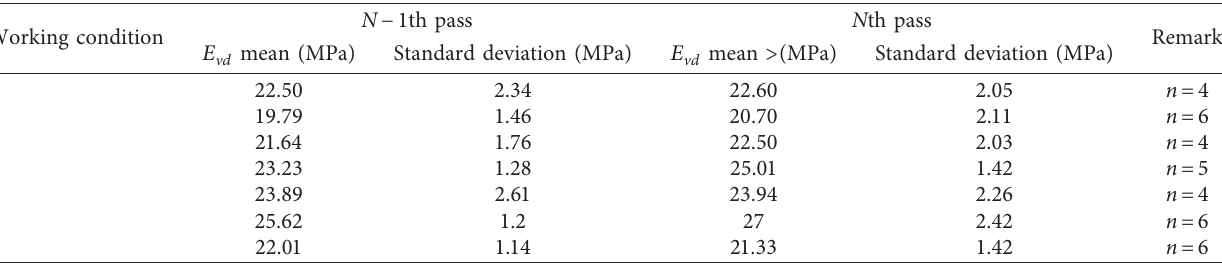
Table 6: Analysis of the results of continuous compaction of PFWD values at the K8 station. N − 1th Working condition